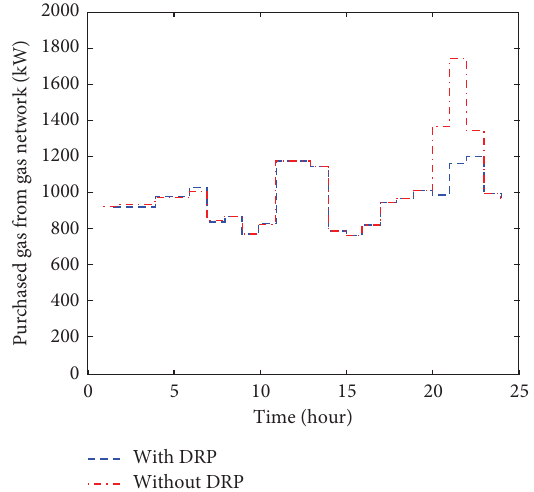
Figure 14: Te gas purchased from the gas network.